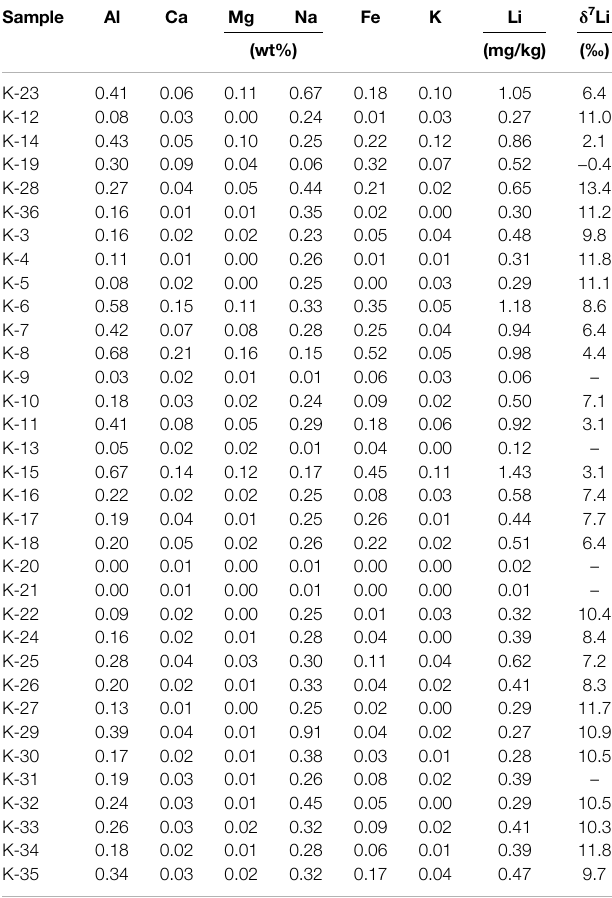
TABLE 2 | Elemental and isotopic compositions for the suspended sediments.